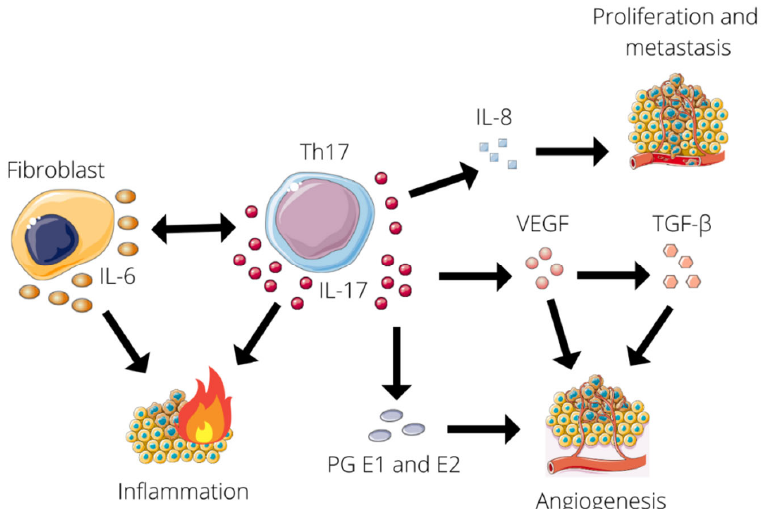
Figure 3. Schematic overview of IL-17’s influence on tumorigenesis. IL-17 stimulates the production of VEGF, PG E1, and E2, IL-6 and IL-8. VEGF triggers VEGF- and TGF- β -mediated angiogenesis, potentiated by the action of PG E1 and E2. IL-6 induces Th17 differentiation and IL-17 expression, stimulating chronic inflammation. IL-8 increases the proliferation and migration of cancer cells.